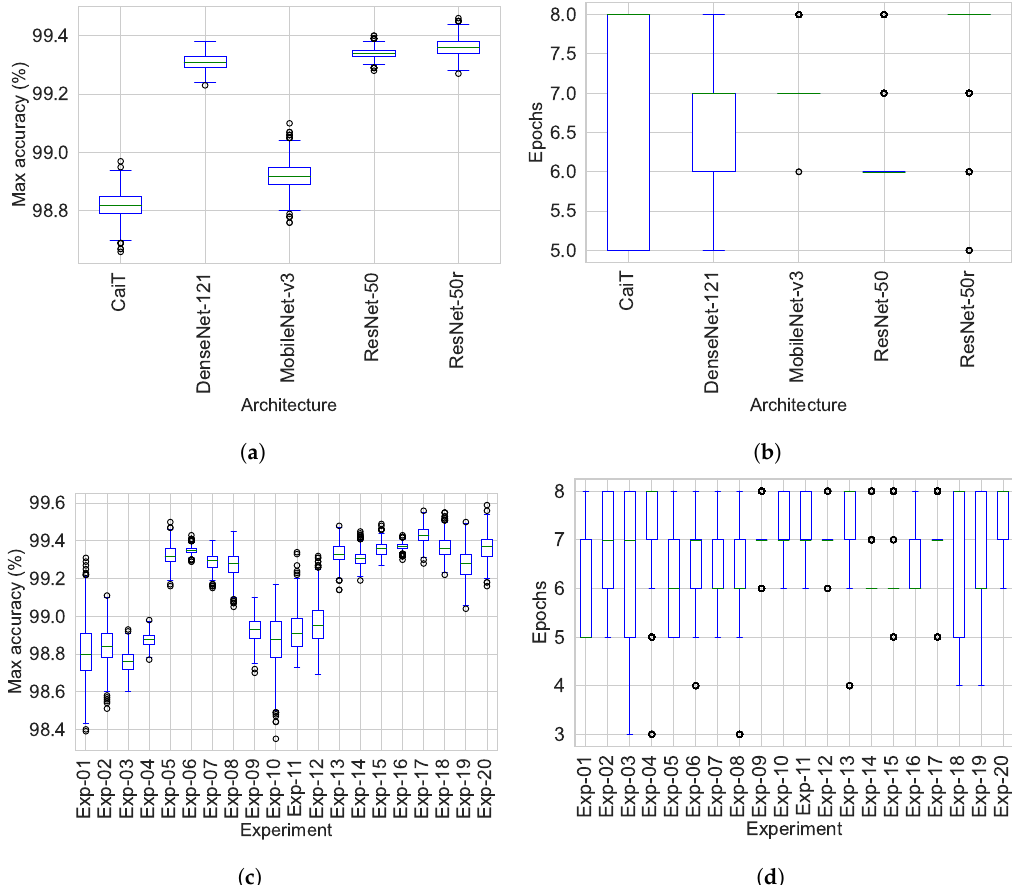
Figure 6. Maximum training accuracy and training epochs to reach the maximum accuracy after 1000 bootstrap cycles. ( a ) Max accuracy by architecture. ( b ) Max accuracy by experiment. ( c ) Epochs required to reach the maximum accuracy by architecture. ( d ) Epochs required to reach the maximum accuracy by experiment. CaiT experiments 1–4, DenseNet experiments 5–8, MobileNet experiments